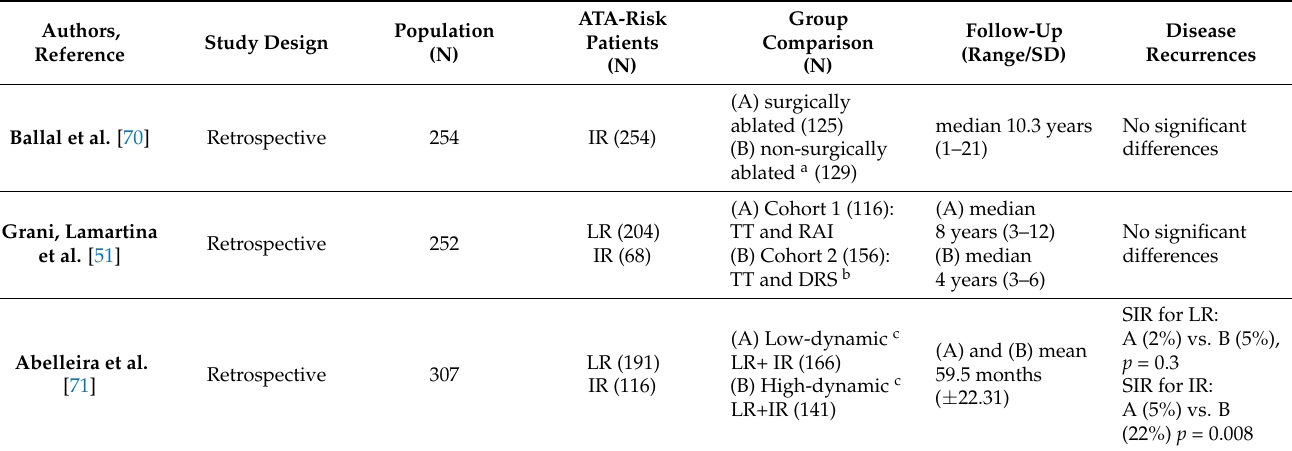
Table 3. Selected use of RAI in intermediate-risk patients after ongoing risk